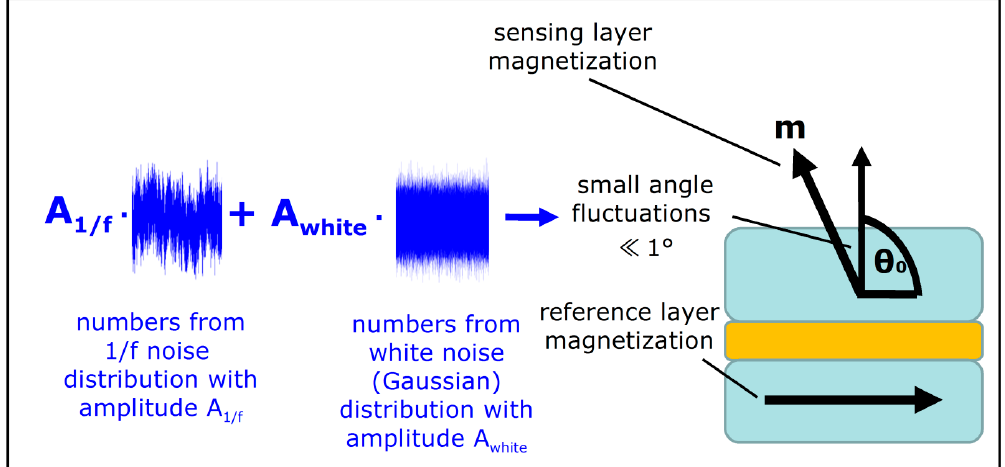
Figure 1. Illustration of the magnetic noise model. Both 1/f noise and white noise contribute to the small angle fluctuations of the sensing layer magnetization.